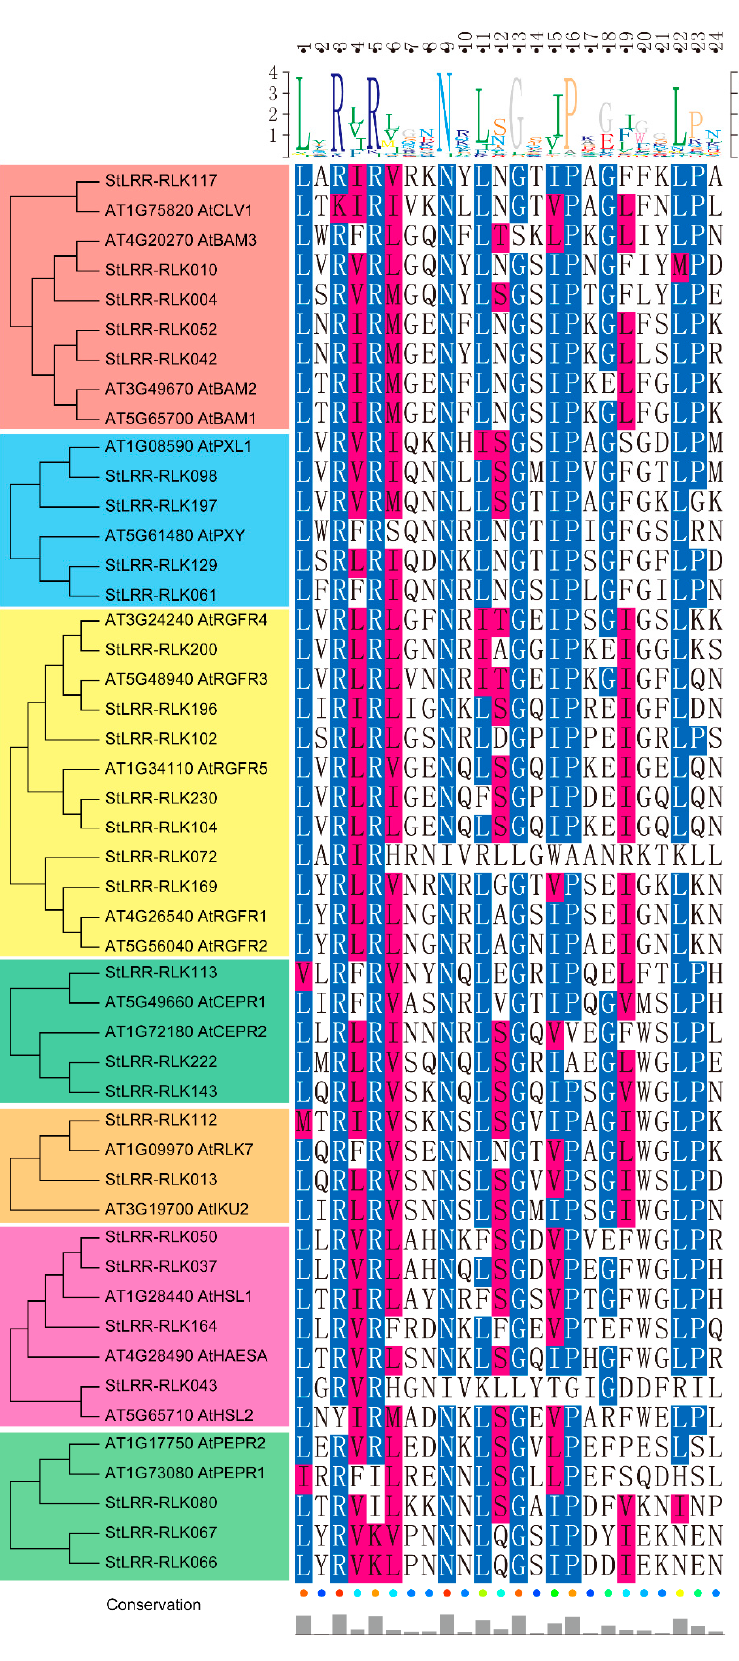
Figure 2. Functional motif analysis of leucine-rich repeat receptor-like kinase (LRR-RLK) members. Sequence alignment of potato and Arabidopsis LRR-RLK members harboring the RxR motif among subfamily IX. The highly conserved residues are blue- or red-colored, and are visualized by Texshade (https://ctan.org/pkg/texshade).